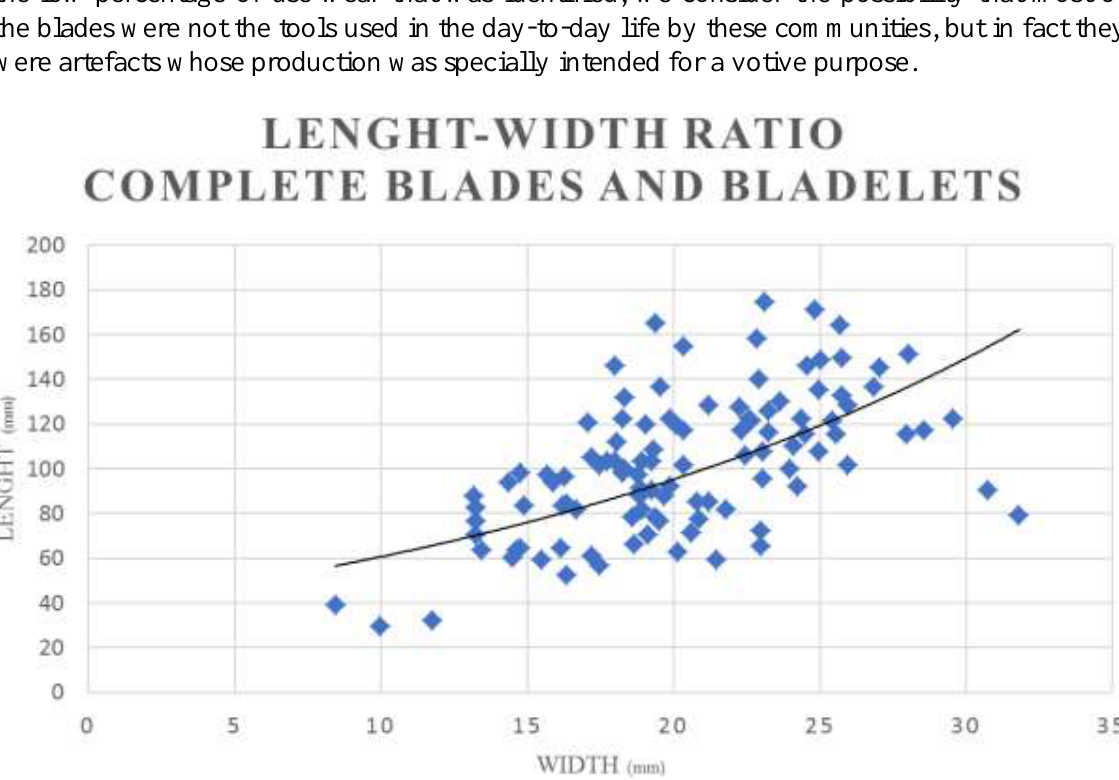
Figure 8. Length to width ratio of the complete blades and bladelets that maintain all their original